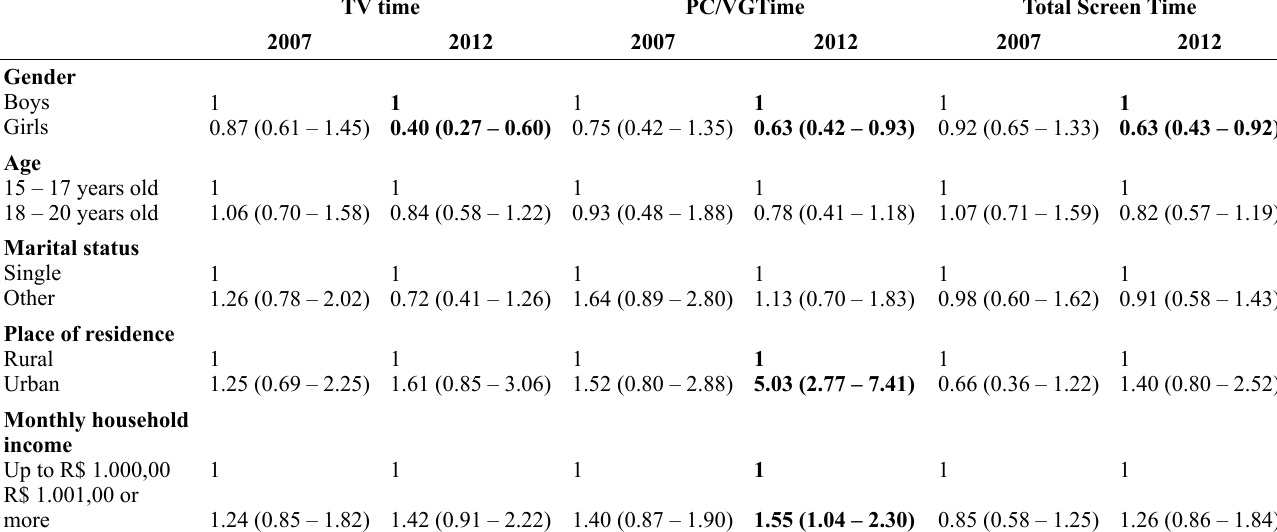
Table 3. Adjusted regression of factors associated with TV time, computer and videogame time, and weekly screen time considering the years of 2007 and 2012 of high school students of the public school network of Caruaru, PE,